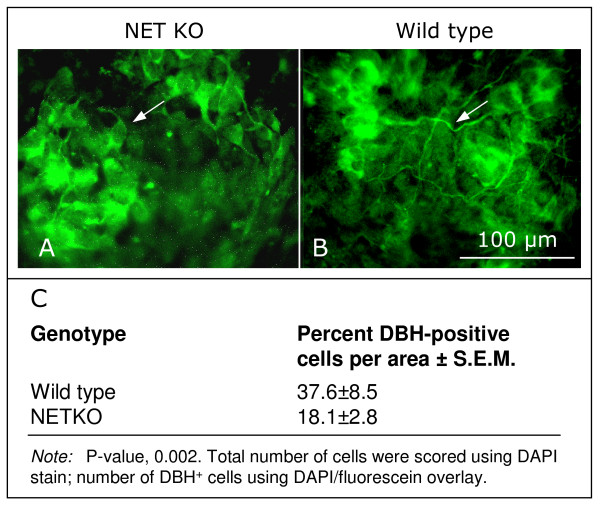
Altered morphology and reduced numbers of DBH-immunoreactive cells in day 7 NETKO neural crest cultures. (A) NETKO neural crest cells have no or short processes only (e.g., arrow). (B) By contrast, wild type DBH-positive cells have long processes (e.g., arrow). (C) Quantification of the number of DBH-immunoreactive cells expressed in day 7 wild type and NETKO neural crest cultures. Approximately half the number of DBH-positive cells is expressed in NETKO cultures compared to wild type cultures. Bar, (A, B) 100 μm.